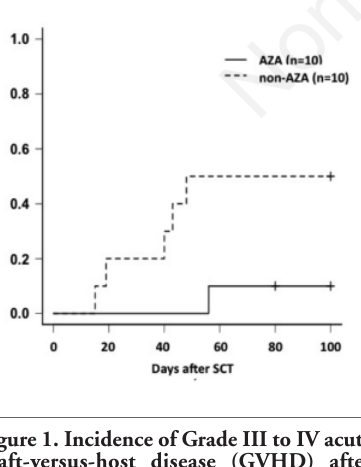
Figure 1. Incidence of Grade III to IV acute graft-versus-host disease (GVHD) after allogeneic stem cell transplantation (allo- SCT) according to pretransplantation ther- apy: azacitidine (AZA) vs non-AZA. Patients were censored at the last follow- up. The difference between AZA and non- AZA was significant at